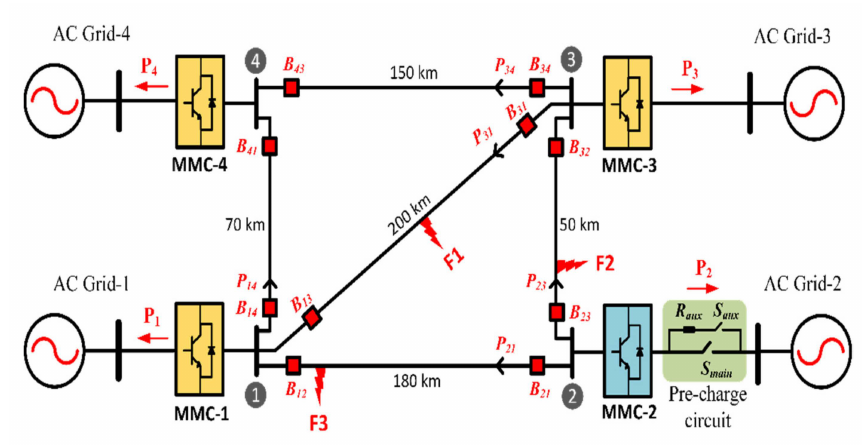
Figure 11. MMC-based MTDC system for the DC fault